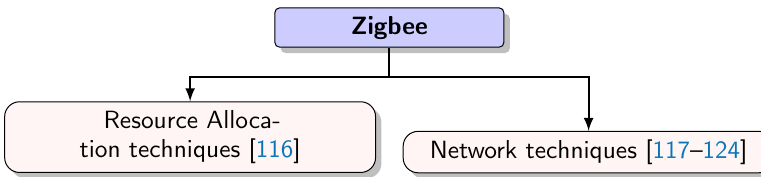
Figure 6. Energy efficiency techniques for Zigbee